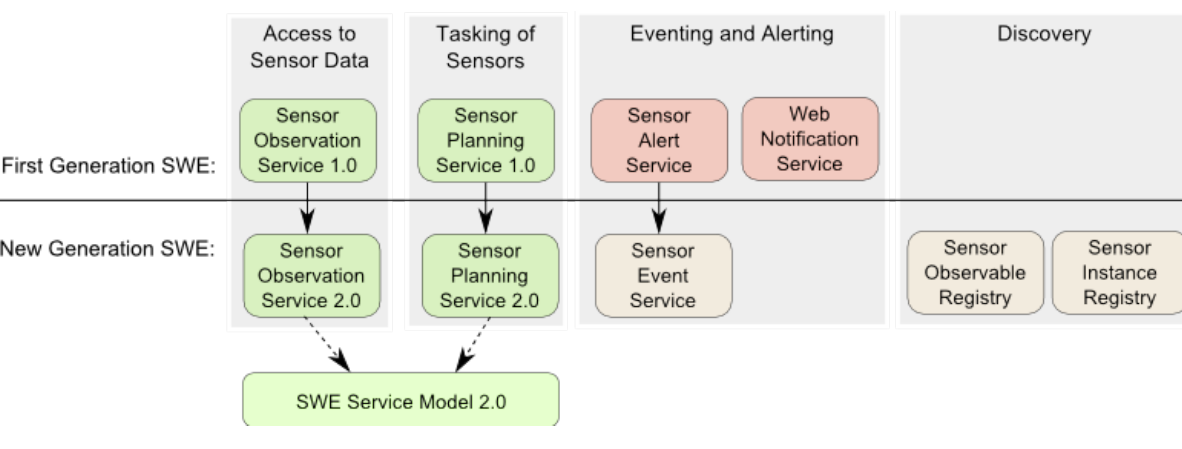
Figure 4. The new generation of the SWE interface model. Green boxes : specifications approved as standards (or in standardization process); Red boxes : best practice specifications which have not been approved as standard; Beige boxes : discussion papers; Solid arrow : ―evolvement to‖; Dashed arrow : ―dependent